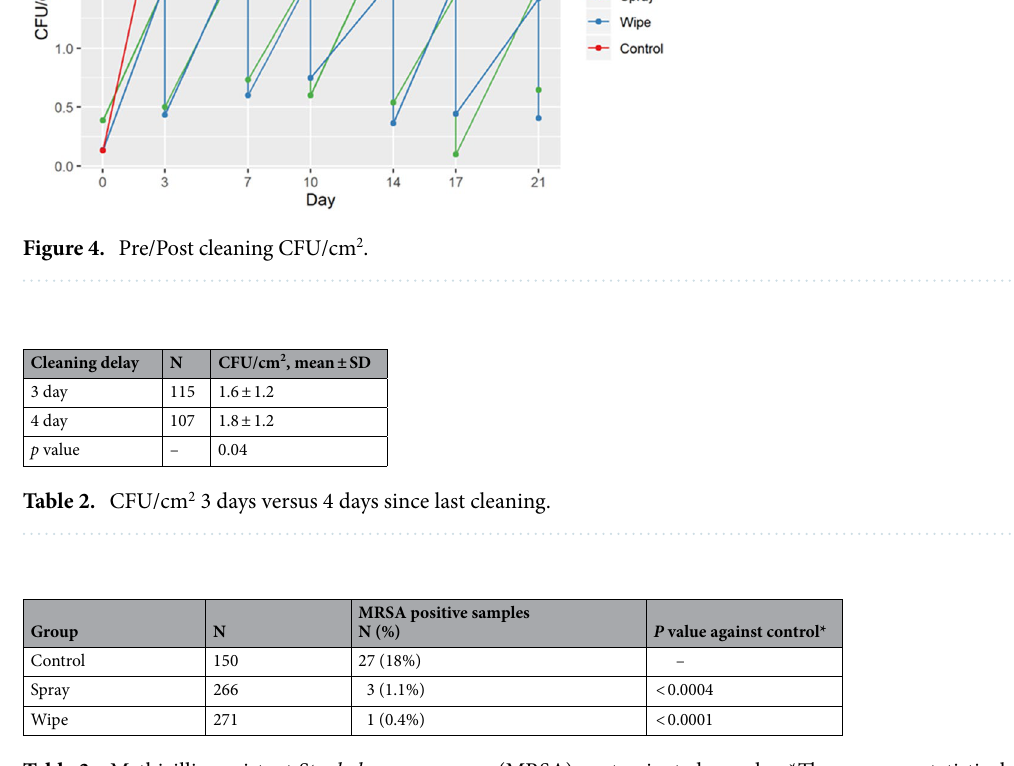
Table 3. Methicillin-resistant Staphylococcus aureus (MRSA) contaminated samples. *There was no statistical difference between spray and wipe groups.